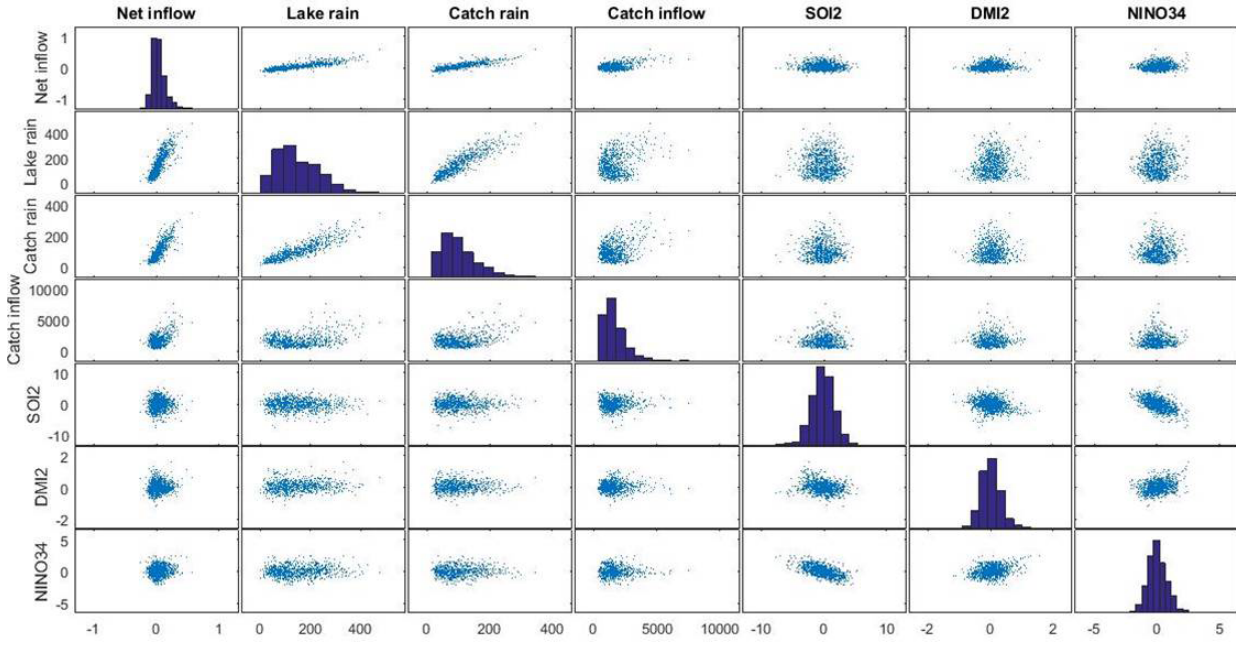
Figure 3. Example of a correlation plot for the standardised monthly records for Lake Victoria (1925–1990) assuming zero lag time between values (Catch = catchment).